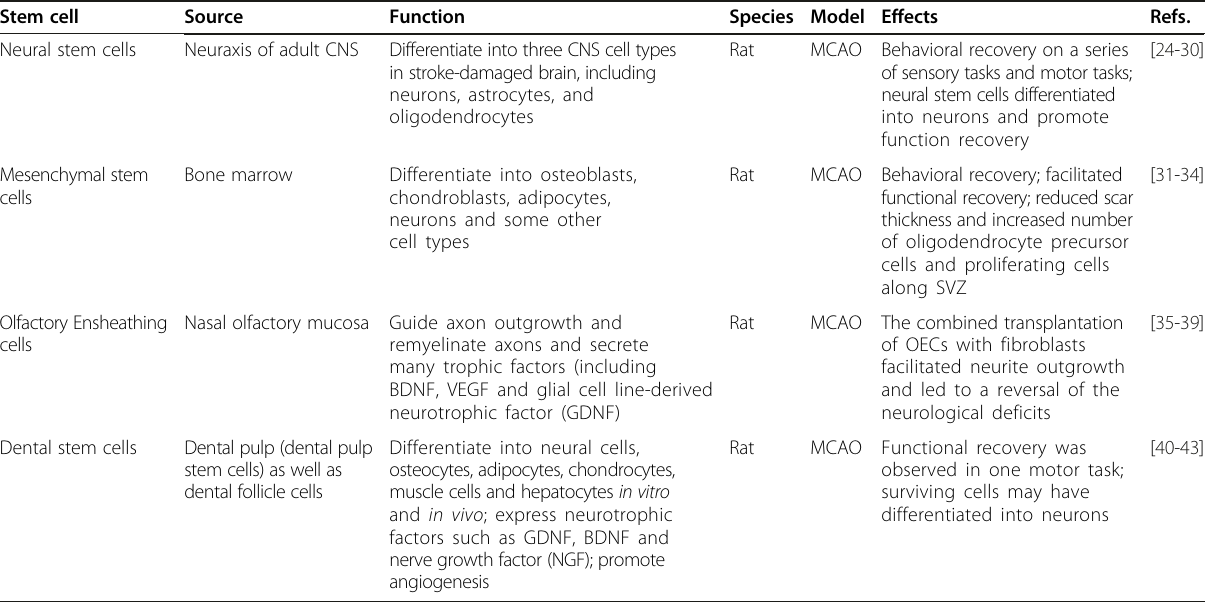
Table 1 Cell therapy used in the treatment of stroke Stem